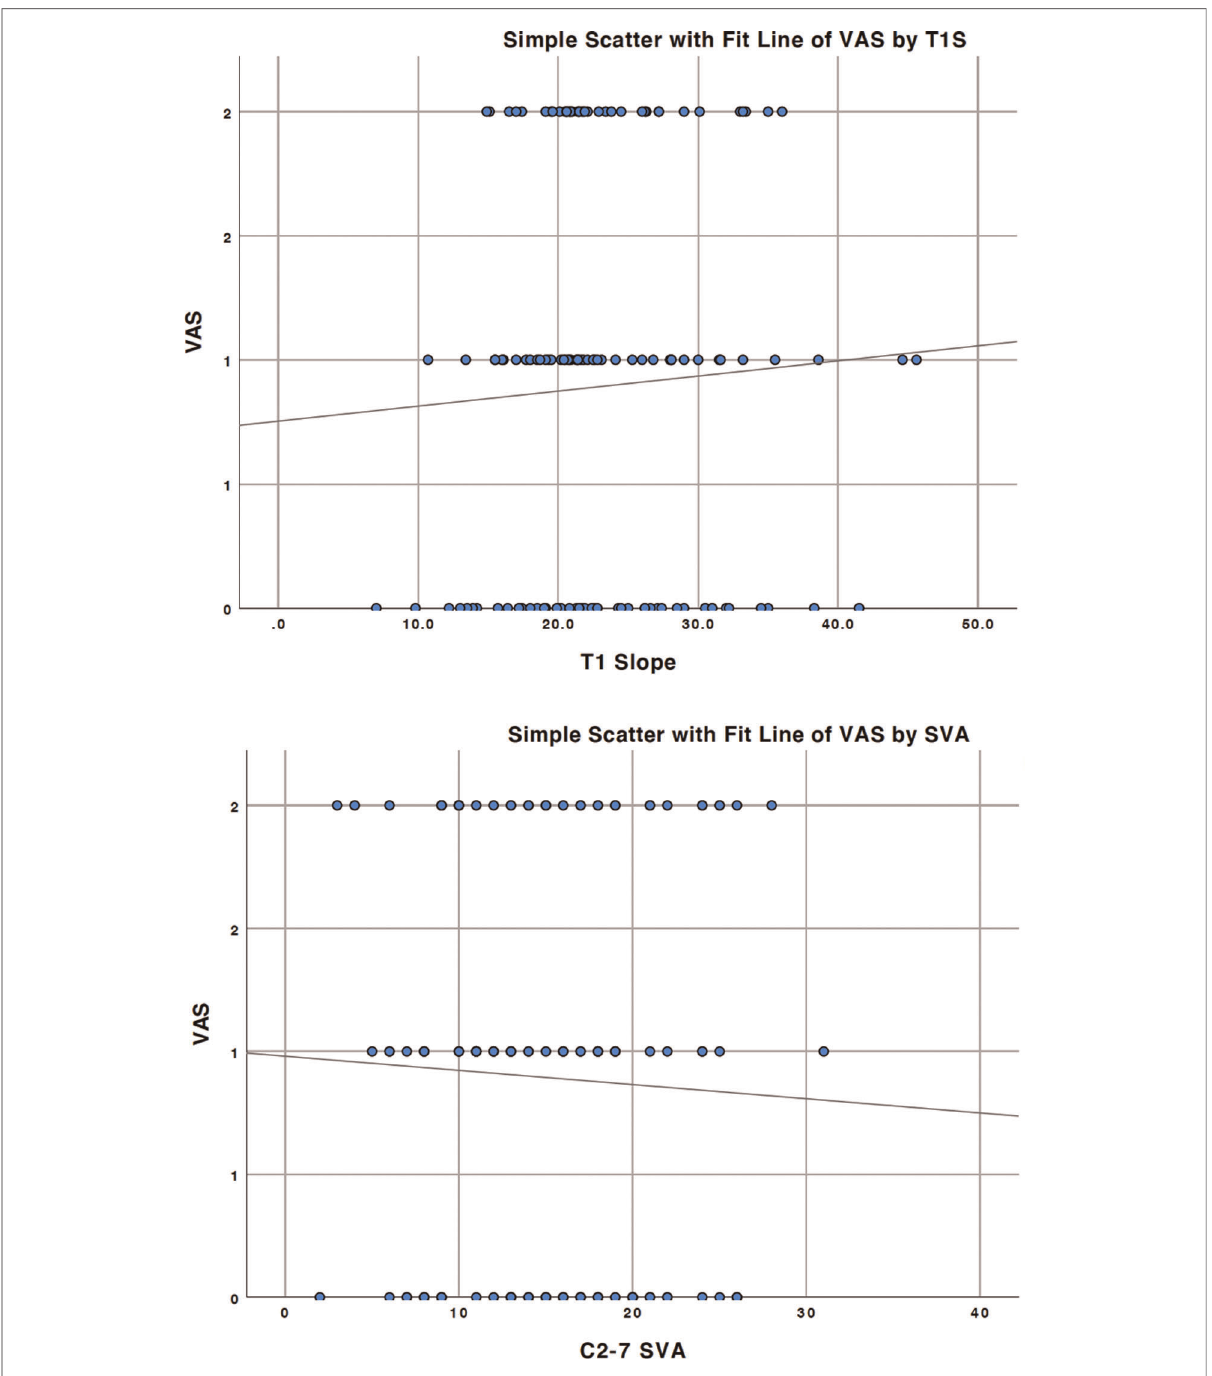
FIGURE 3 Simple scatter with fi t line of preoperative VAS by T1 slope and C2 – 7 SVA, with a p value of 0.510 and 0.467,